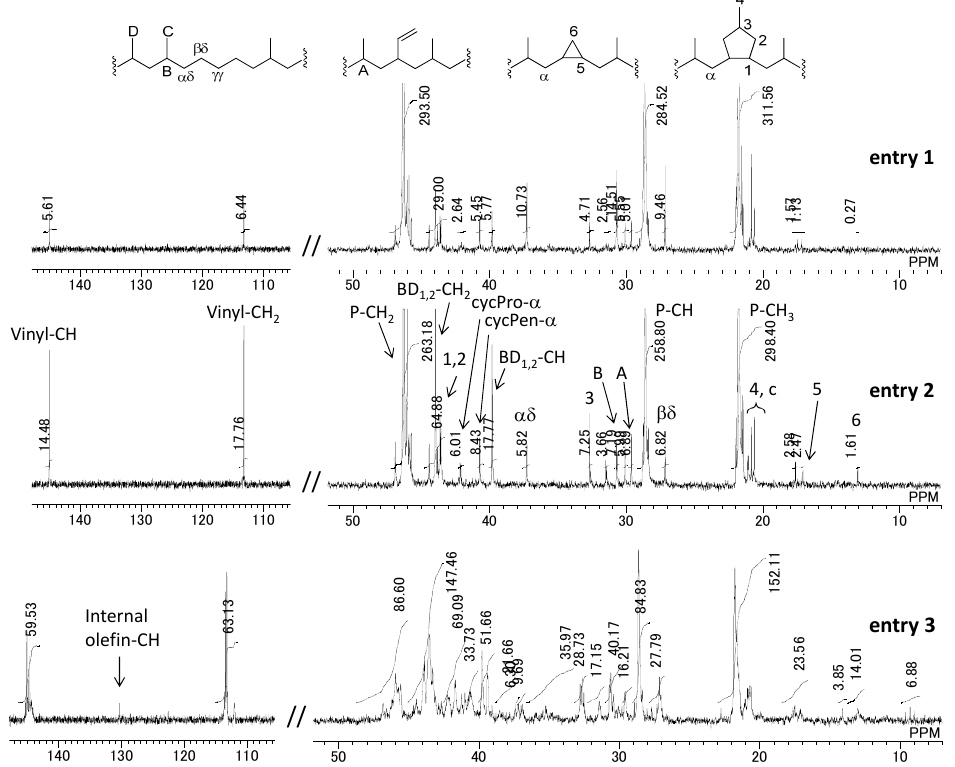
Figure 6. 13 C-NMR spectra of the propylene/butadiene copolymers obtained from the runs 1, 2, and 3 of Table